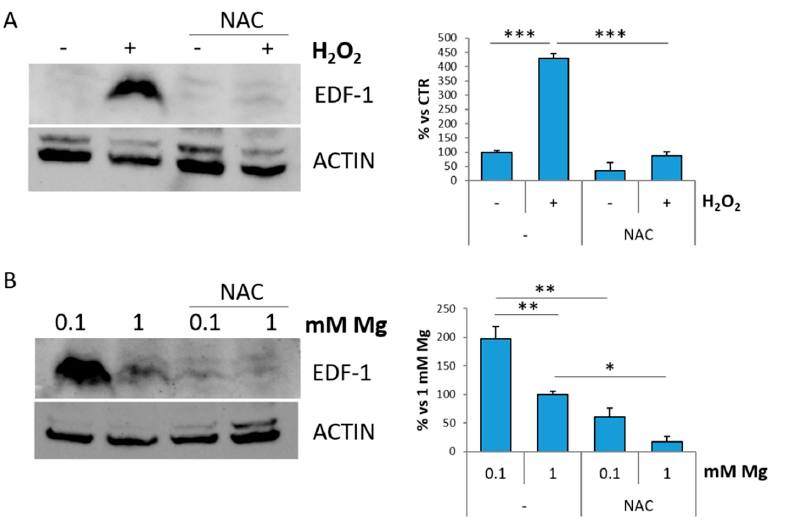
Figure 3. Oxidative stress induces EDF-1. ( A ) HUVEC were pretreated or not with NAC (5 mM) for 1 h, exposed or not to H 2 O 2 (200 µ M) for 30 min and extracted 24 h later. ( B ) HUVEC were cultured in 0.1 or 1 mM of Mg in the presence or in the absence of NAC (5 mM) for 24 h. Western blot was performed using antibodies against EDF-1. Actin was used as a control of loading. A representative blot is shown. Densitometry (right panel) was performed on three different blots using Image J. * p ≤ 0.05, ** p ≤ 0.01 and *** p ≤